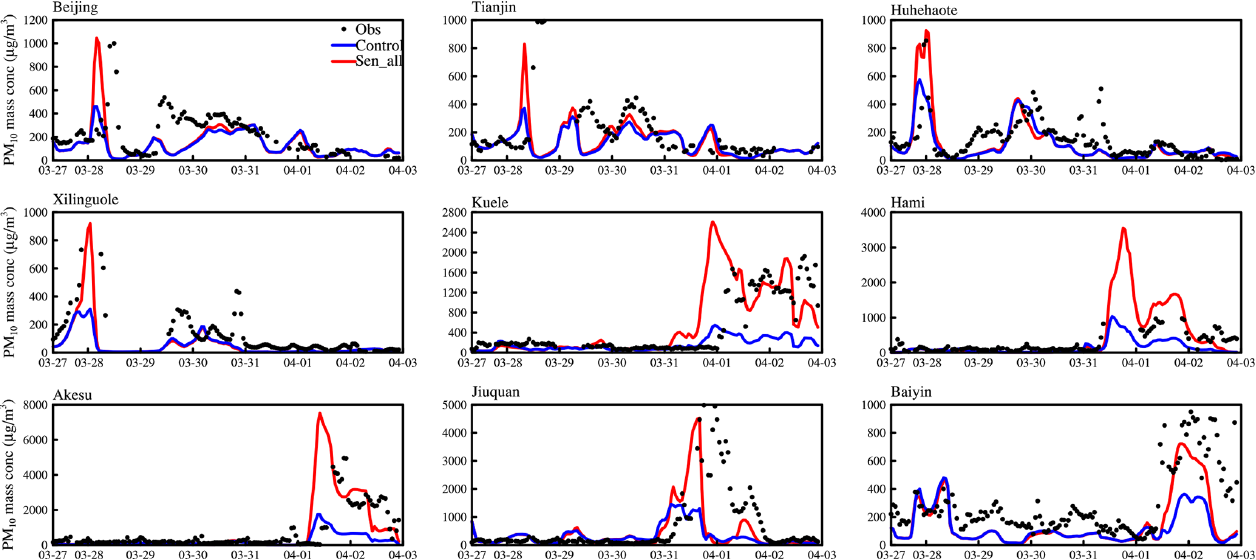
Figure 9. Temporal variation of hourly PM 10 concentrations from observations (black dots) and simulations of the control run (blue line) and Sen_all (red line) during the study period at nine selected